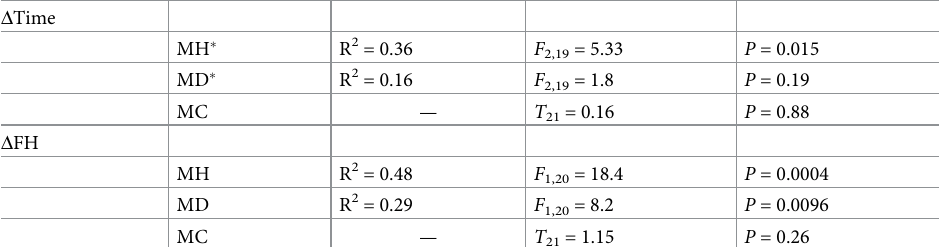
Table 1. Effects of male behavior and color on female preference. Δ Time MH � R 2 = 0.36 F 2,19 = 5.33 P = 0.015 MD � R 2 = 0.16 F 2,19 = 1.8 P = 0.19 MC — T 21 = 0.16 P = 0.88 Δ FH MH R 2 = 0.48 F 1,20 = 18.4 P = 0.0004 MD R 2 = 0.29 F 1,20 = 8.2 P = 0.0096 MC — T 21 = 1.15 P = 0.26 Results of female choice experiment in which female lizards were presented with one brown and one orange male. The difference in the amount of time spent with the brown and orange male ( Δ Time) and the difference in the number of head-bobs performed at each male ( Δ FH) are measures of female preference. MH = number of male head- bobs directed towards the female. MD = number of male dewlaps directed towards the female. MC = male color (brown or orange). Asterisks ( � ) indicate values that were controlled for mass.